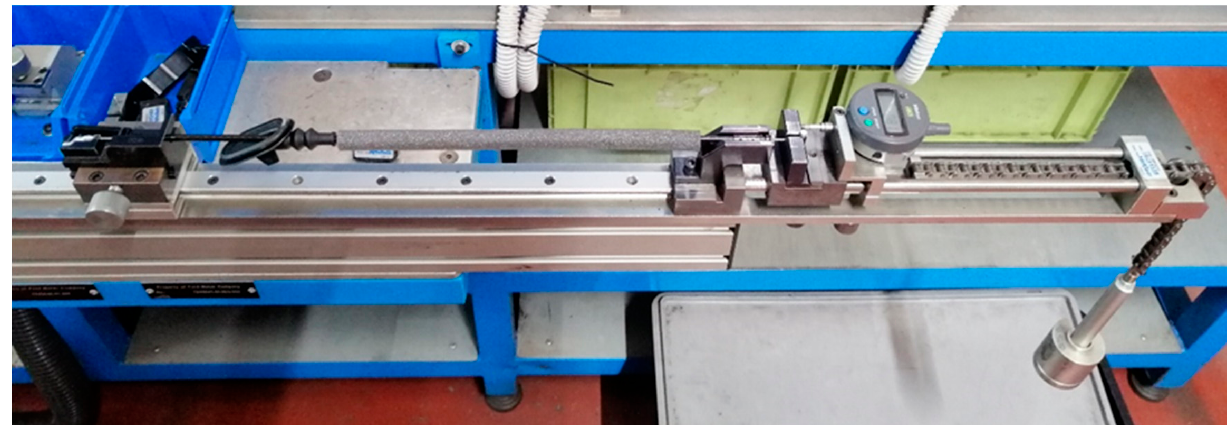
Figure 23. Validation of the produced control cable after changing the equipment.